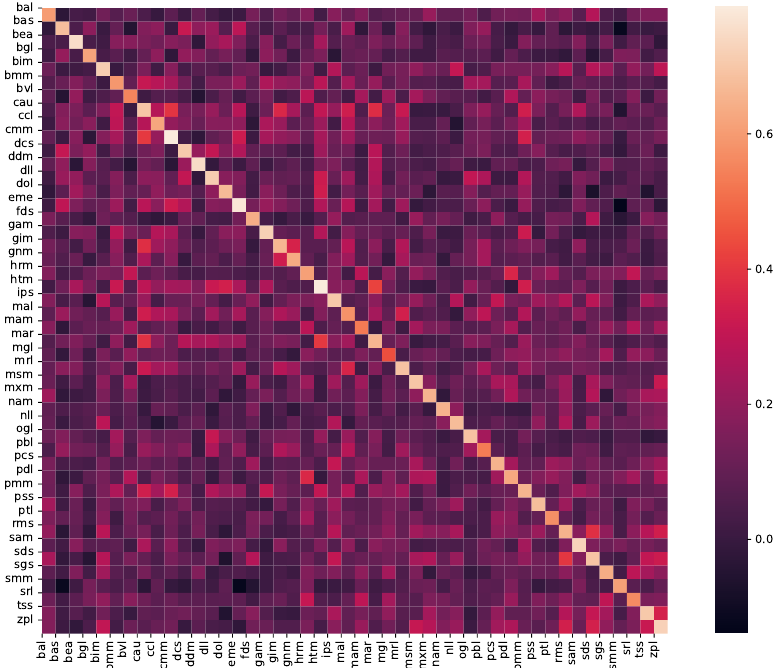
Figure 3. Inter-speaker similarity matrix for the NeMo ECAPA-TDNN